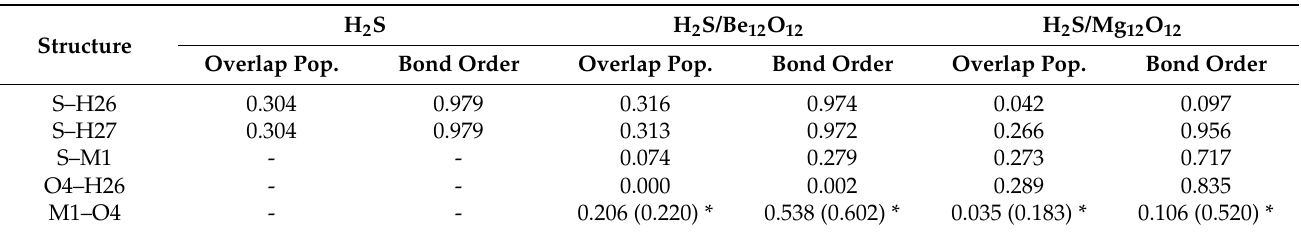
Table 5. Overlap population and bond order of H 2 S, H 2 S/Be 12 O 12 , and H 2 S/Mg 12 O 12 . H 2 S H 2 S/Be 12 O 12 H 2 S/Mg 12 O 12 Structure Overlap Pop. Bond Order Overlap